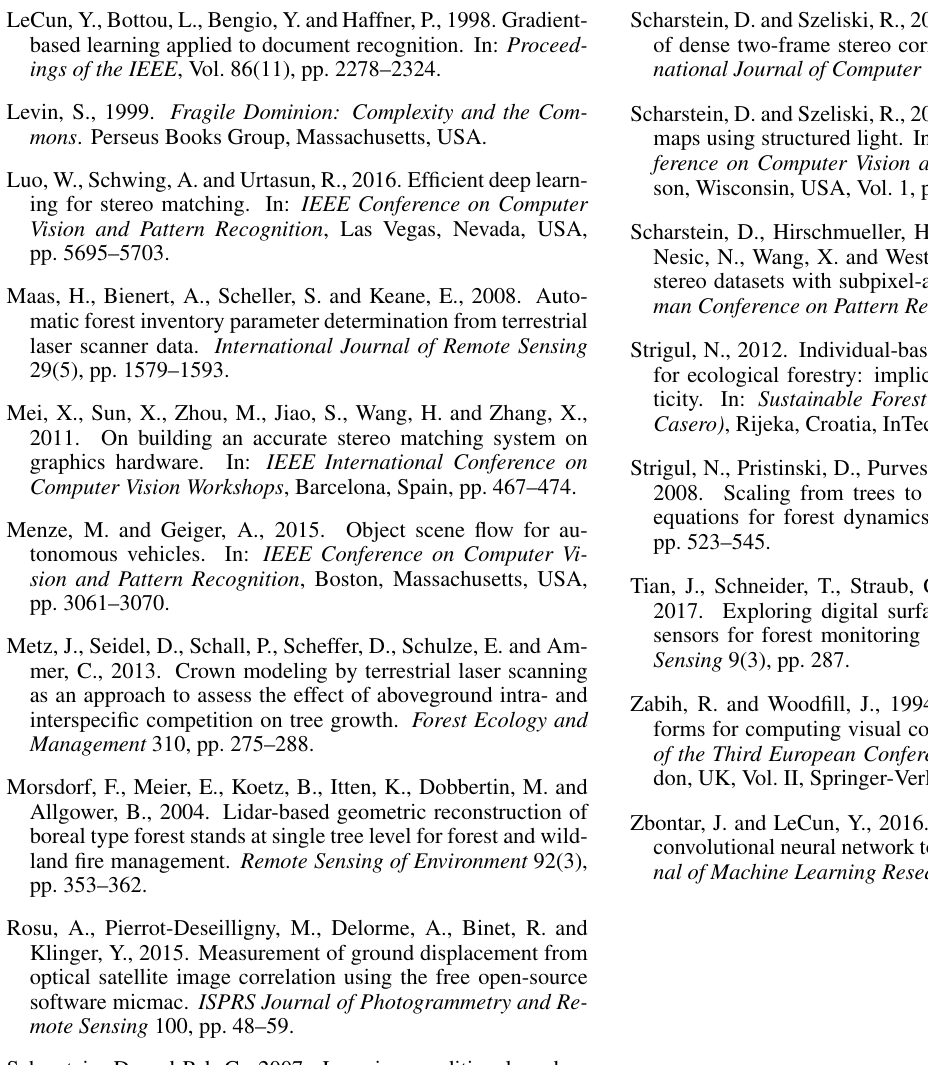
Figure 8. The cropped region from the master epipolar image of stereo pair 1, reference disparity map and disparity map A, B and